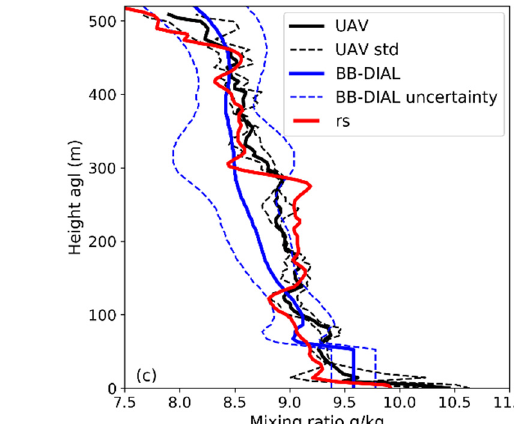
Figure 9. UAV, BB-DIAL and radiosonde inter-comparison, ~09:00, 25 June 2020. UAV flight time-height cross section for ( a ) mixing ratio and ( b ) temperature. The vertical blue line in ( a ) is the mid-point of the flight used for the time collocation with the BB-DIAL data. ( c ) Mixing ratio vertical profile for BB-DIAL (blue), BB-DIAL uncertainty (blue dash), radiosonde (red) and UAV (black). The UAV ascent and descent mixing ratio data are averaged over 4.8 m. The solid black line is the average mixing ratio and the dashed black line the standard deviation for this sample of typically around 100 values.